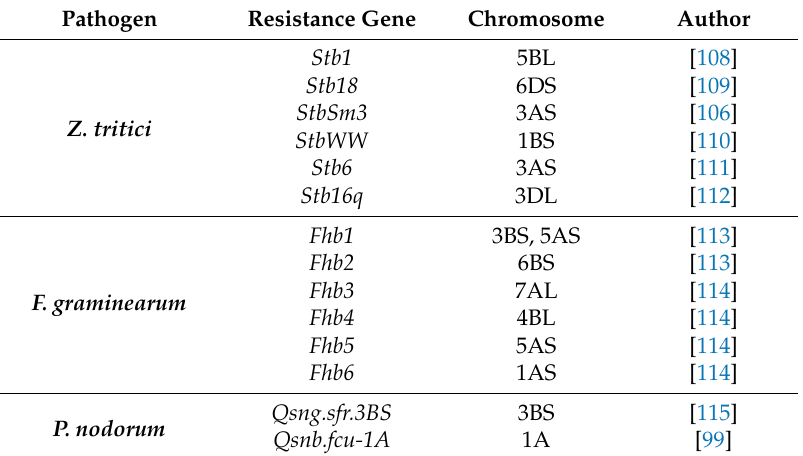
Table 2. Genes encoding resistance to selected pathogens in